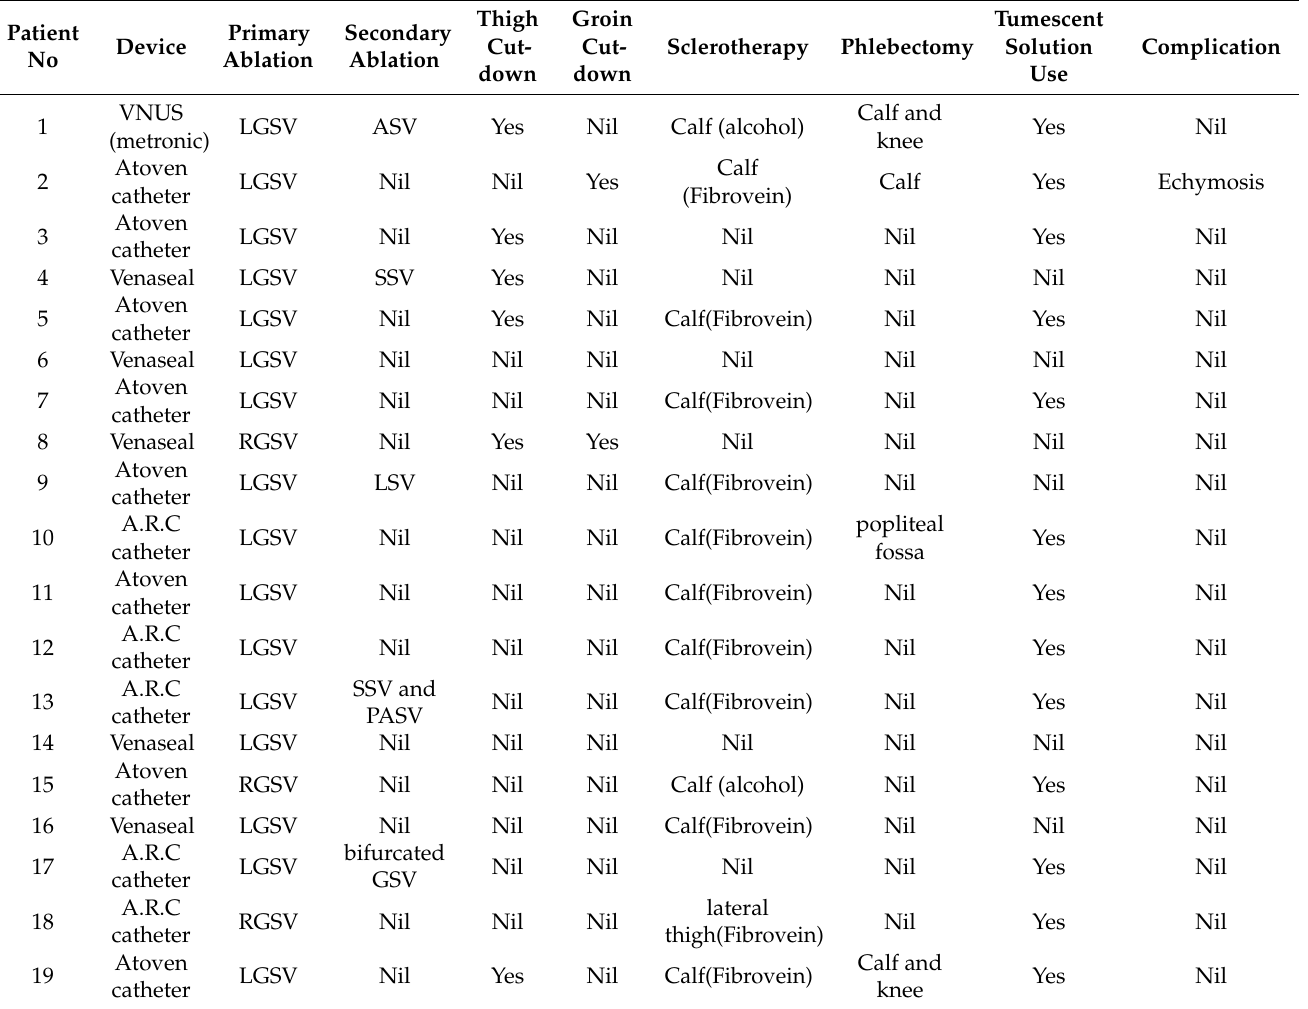
veins less than 1 cm in diameter were treated through sclerotherapy. Table 2. Interventional data of the 25 patients with symptomatic varicose vein TRANCE MR as preoperative evaluation.